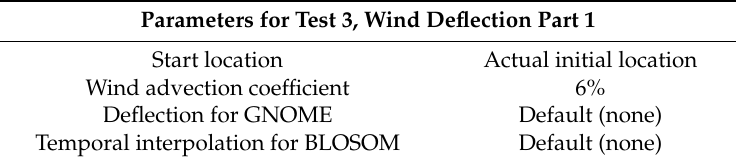
Table 5. Parameters for test 3, wind deflection part 1.